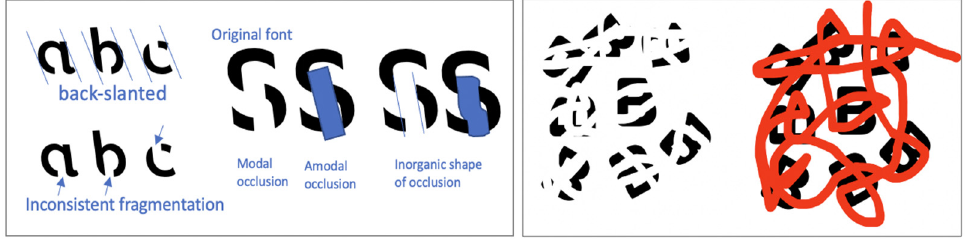
Figure 2. Left panel showing key characteristics of SF that creates visual difficulties. For example, the gap at letter c is positioned such that little continuation is suggested from the left to the right piece. Likewise, the gaps at letter S are positioned such that no strong connection is suggested by the three pieces. Right panel is a recreation of stimuli from Bregman [20]. Figure 1. Sample of Sans Forgetica (SF) typeface. (SF is licensed under the Creative Commons At-